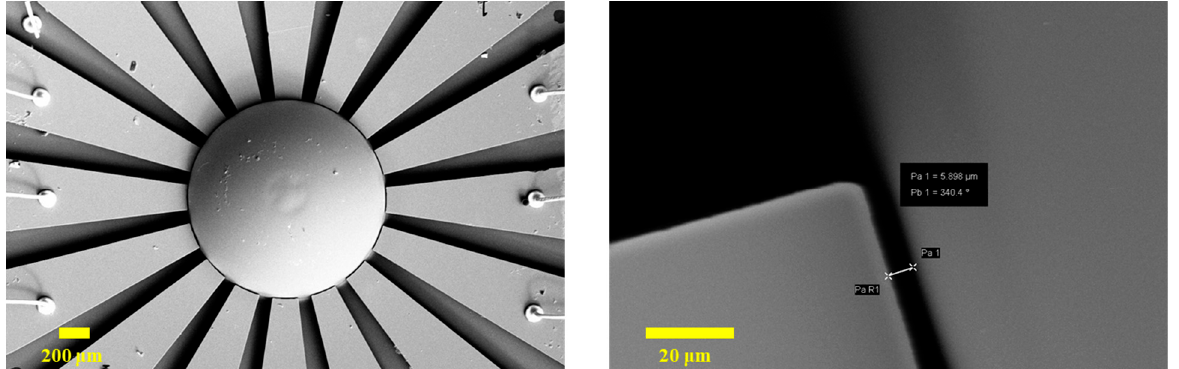
Figure 8. SEM pictures of μ HR.